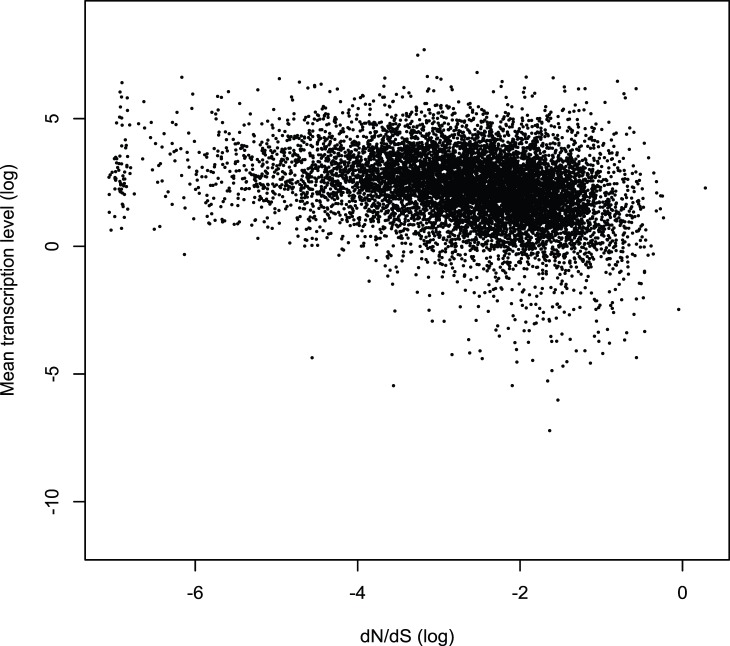
Mean transcription levels in mouse cortex and the evolutionary rates (dN/dS) of these genes are negatively correlated (Spearman's r  = −0.34,
p
<2.2×10
−16
).